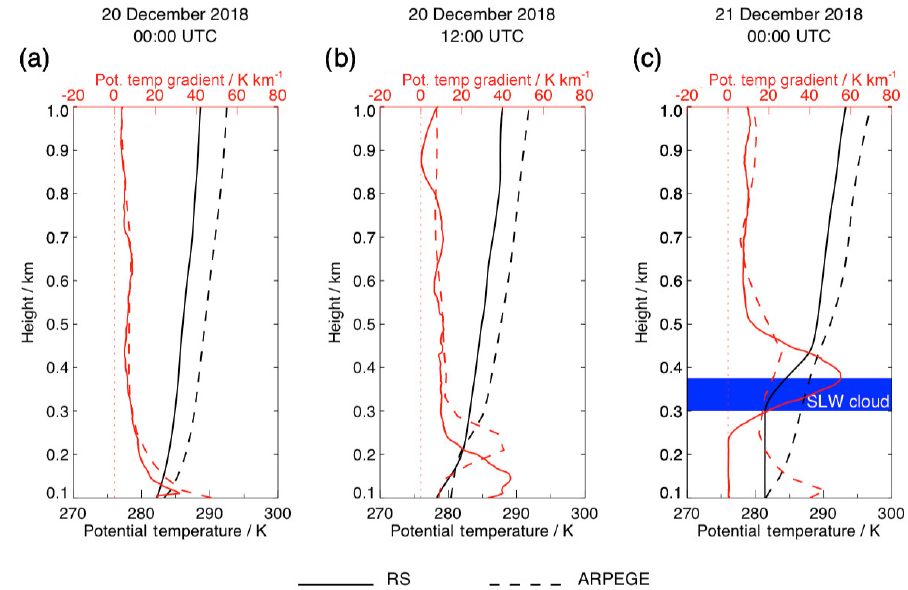
Figure 14. Same as Fig. 8 but on 20 December 2018 at (a) 00:00 and (b) 12:00UTC and (c) on 21 December 2018 at 00:00UTC.